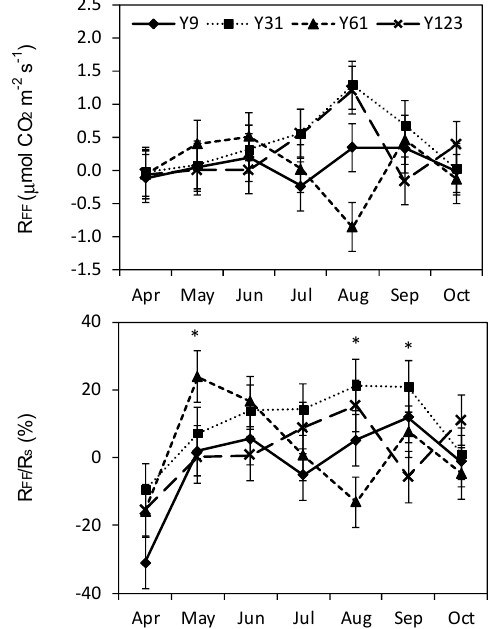
Figure 2. CO 2 efflux from forest floor layers (R FF , top panel) and the percentage of total soil respiration (R S ) represented by the forest floor (bottom panel) in 9, 31, 61, and 123 year-old red pine stands in northern Minnesota, USA. Error bars indicate standard error. An asterisk indicates a month with significant differences among stand ages. R FF estimates displayed here reflect the mean of values calculated from two separate treatments (complete litter removal and temporary removal of litter in a mesh bag).